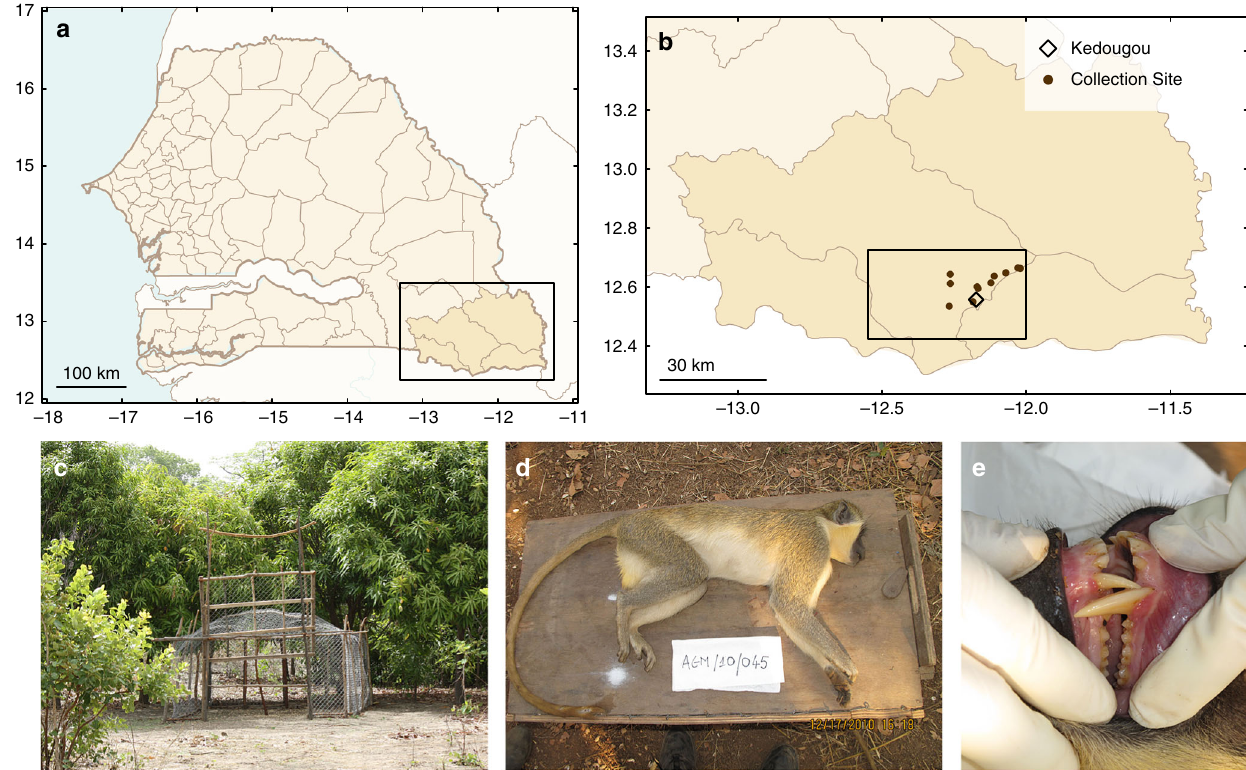
Fig. 1 Monkey collection sites and sample individual. a A map of Senegal with the Kédougou Department boxed. b A map of the Kédougou region with the study region boxed and presented in detail in Fig. 2. c A typical trap, and d , e shows a male C. sabaeus estimated to be ~5 years (between 4 and 6 years) of